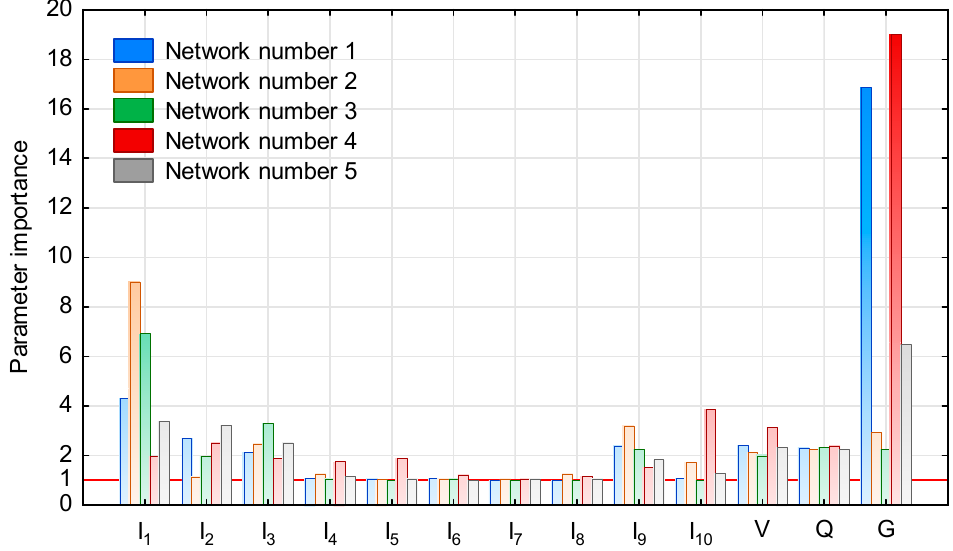
Figure 8. Sensitivity analysis of all the variables that were used to build the network.